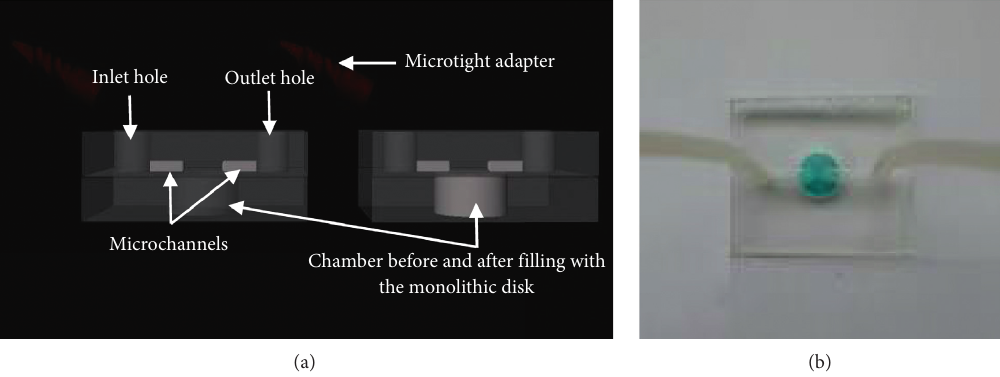
Figure 8: Schematic diagram and a photograph of the polycarbonate microchip. The top and base plates were 13.5mm in length and width and the thickness was 2.8mm. The top plate contained two microchannels (length 4mm, width 1mm, and depth 1mm) and two access holes (1.5mm) for attachment of ETFE tubing while the base plate contained the extraction chamber (6.5mm width and 2mm depth).